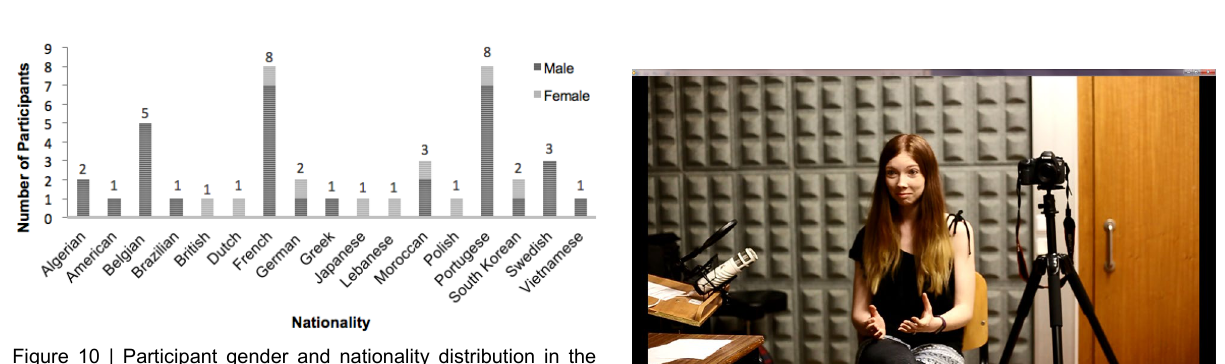
Figure 10 | Participant gender and nationality distribution in the database. Figure 11 | An example of captured video